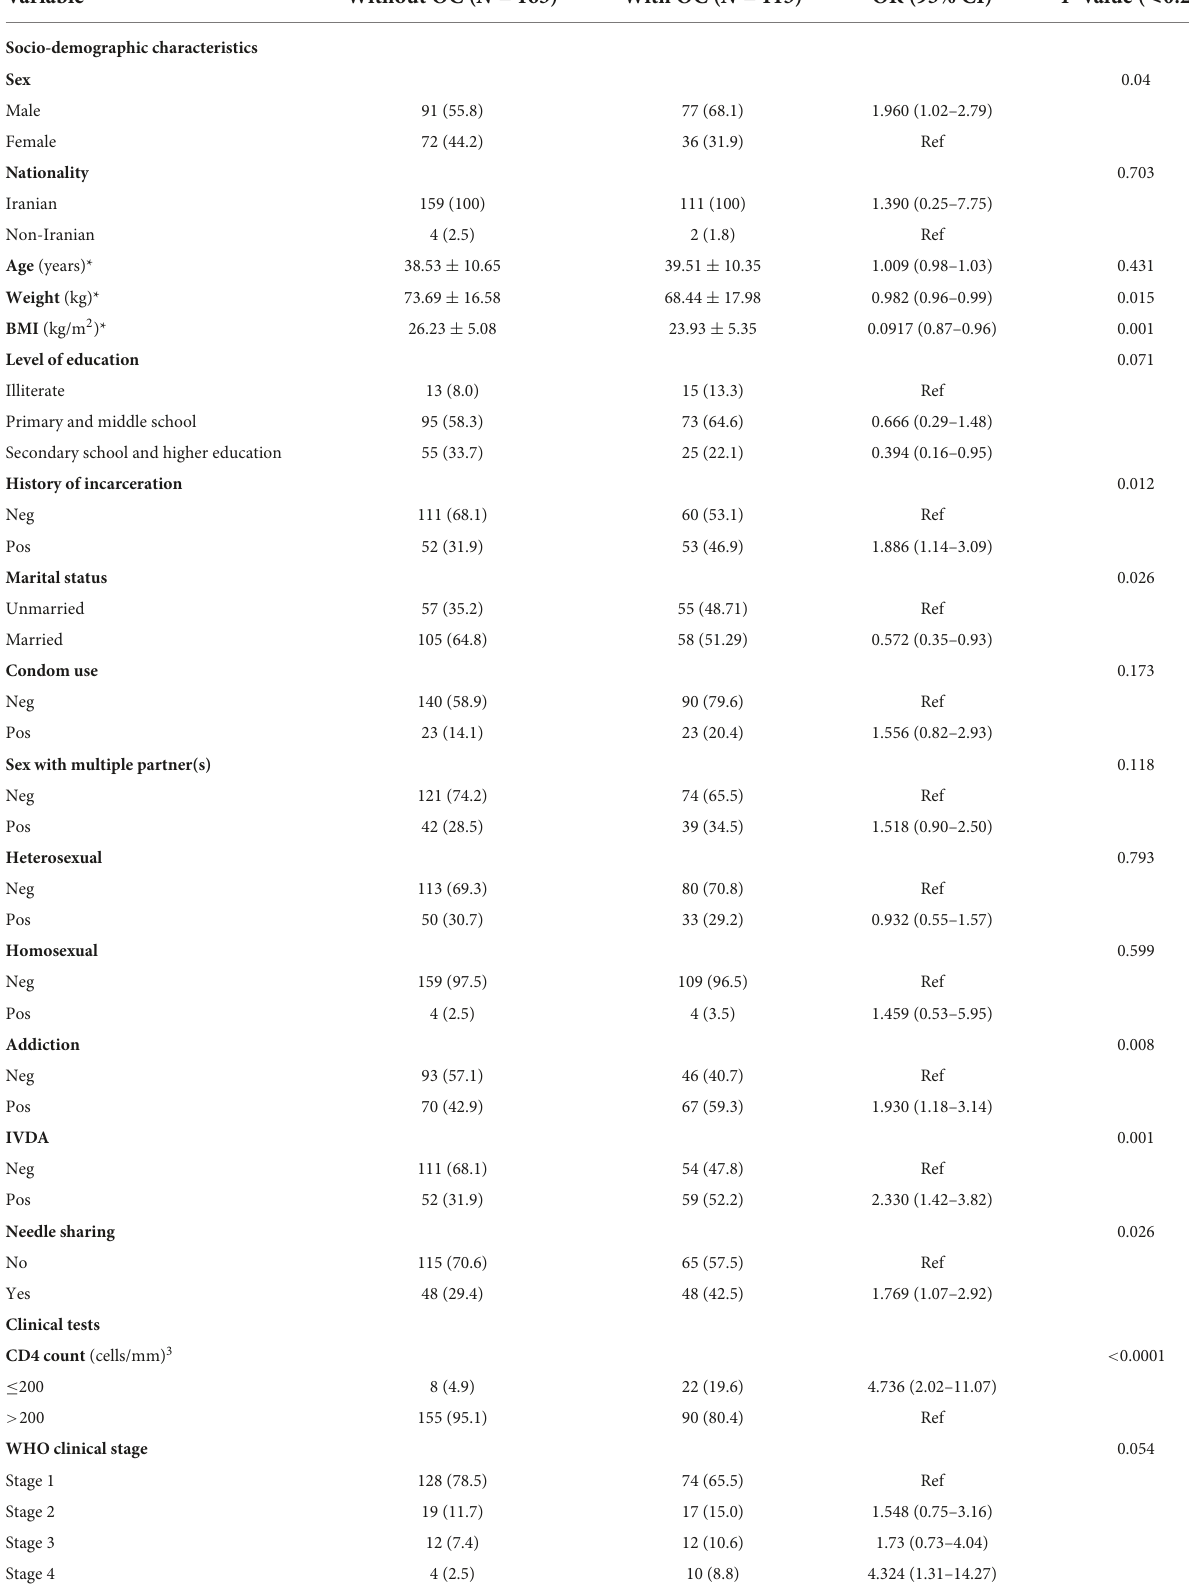
TABLE 3 The important risk factors for oral Candidiasis (univariate logistic regression).